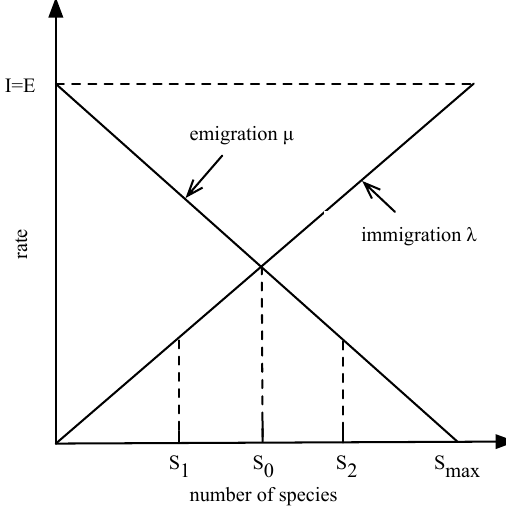
Figure 1. The relationship of fitness of habitats (species count), immigration rate λ and emigration rate µ . S 1 is a relatively poor solution, whereas S 2 is a relatively good